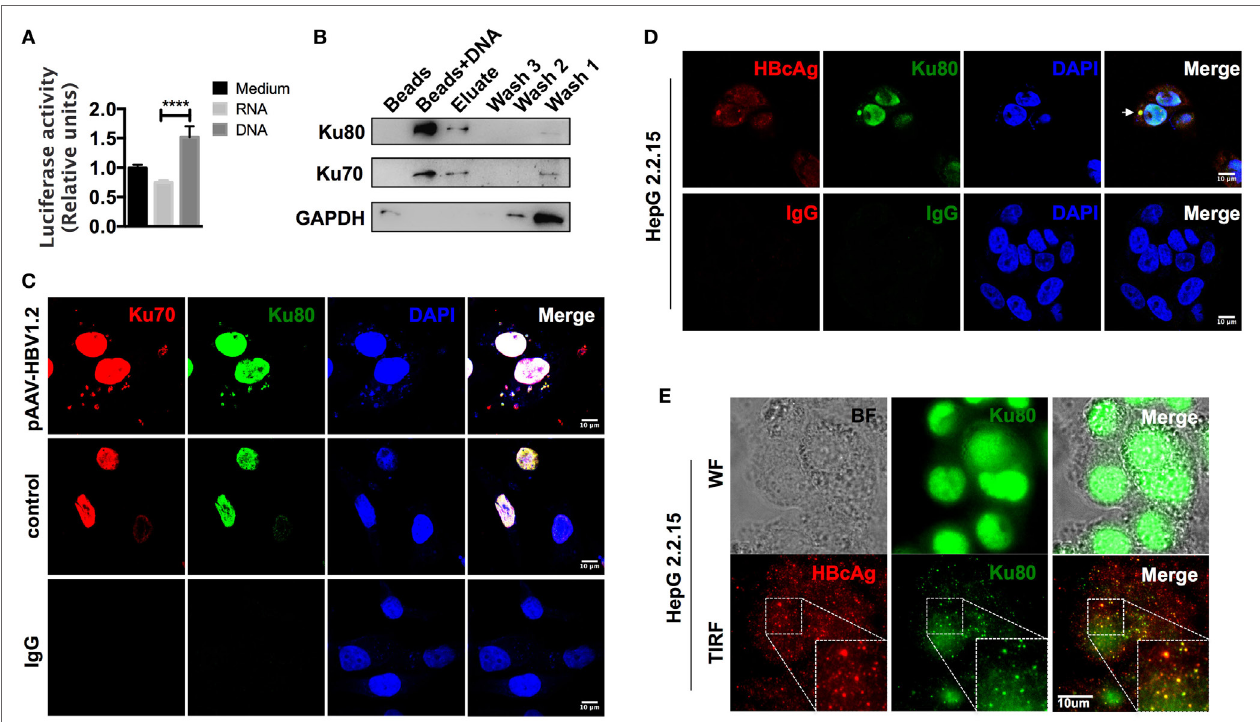
FigUre 4 | The cytoplasm-translocated Ku70/80 complex recognizes transfected hBV Dna . (a) Total RNA and cytoplasmic DNA were isolated from HepG 2.2.15 cells. RNA or DNA (1 μ g/ml) was transfected into pCCL3p-luc-eGFP-expressing SK-Hep-1 cells. Forty-eight hours later, 150 μ g/ml of firefly luciferin was added to the supernatant, and bioluminescence was determined immediately ( n = 4). (B) Biotin-labeled HBV DNA was transfected into SK-Hep-1 cells. Six hours later, the cells were lysed, and the DNA-binding proteins were immunoprecipitated with a μ MACS kit. Only beads were used as a control. Three rounds of column wash fluid (lysis buffer, marked Wash1–Wash3) were collected together with the high-salt eluent (1 M NaCl in lysis buffer, marked Elute) and the beads on the column (Marked Beads + DNA). Then, SDS-PAGE was carried out for Western blotting. (c) The pAAV-HBV1.2 plasmid was transfected into SK-Hep-1 cells. The cells were then fixed with PFA, and immunofluorescence staining was performed. An equal amount of medium or isotype IgG was applied as a control. Scale